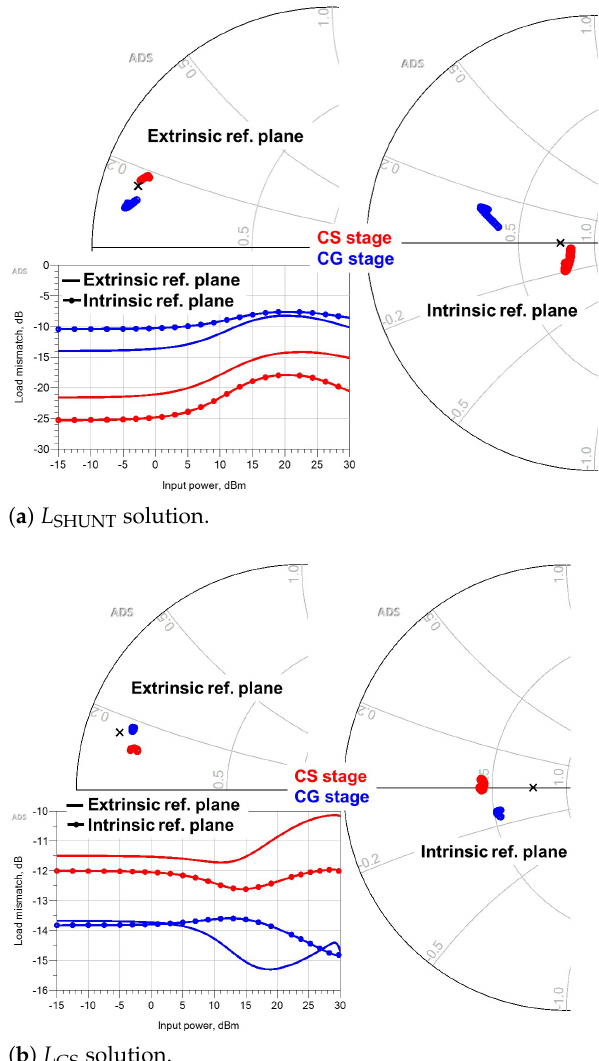
Figure 11. Load of CS (red) and CG (blue) stages as a function of input